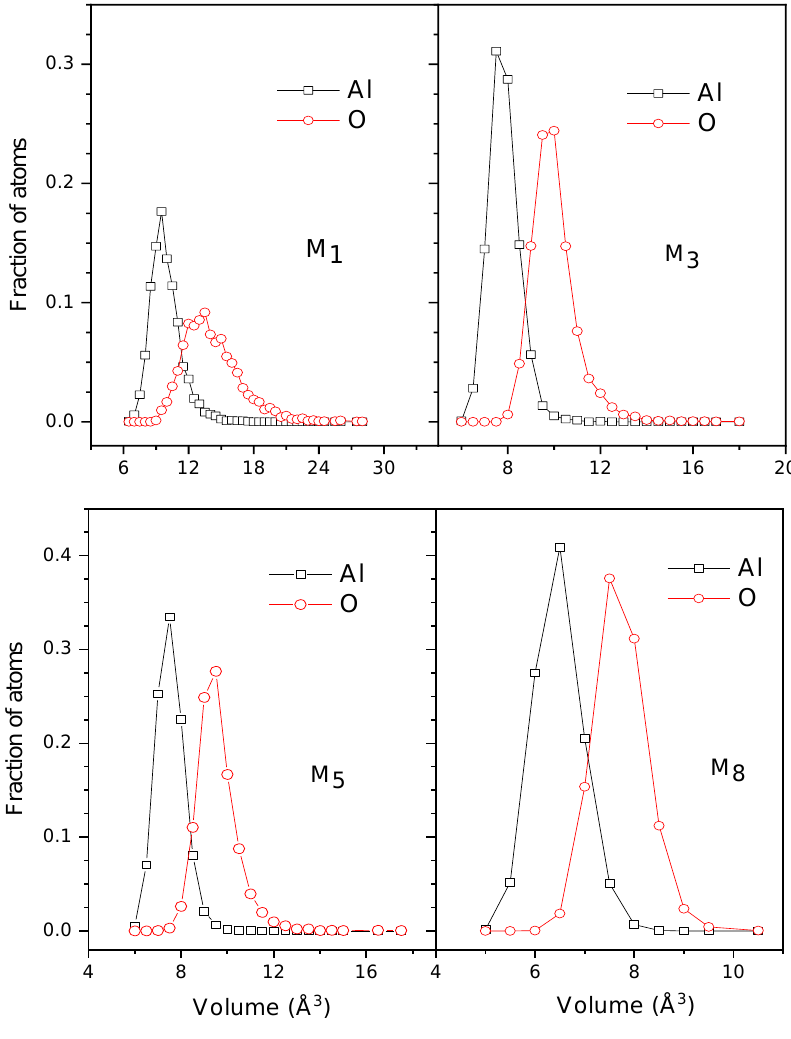
Figure 5. Dependence of fraction of Al and O on Voronoi volume at 0, 10, 20 and 40 GPa. Fraction of Al, O is given respectively by m ( υ Al )/ m Al and m ( υ O )/ m O with m ( υ Al ), m ( υ O ) is the number of Al and O having volume υ Al and υ O , respectively. m Al and m O are the total number of Al and O, respectively.